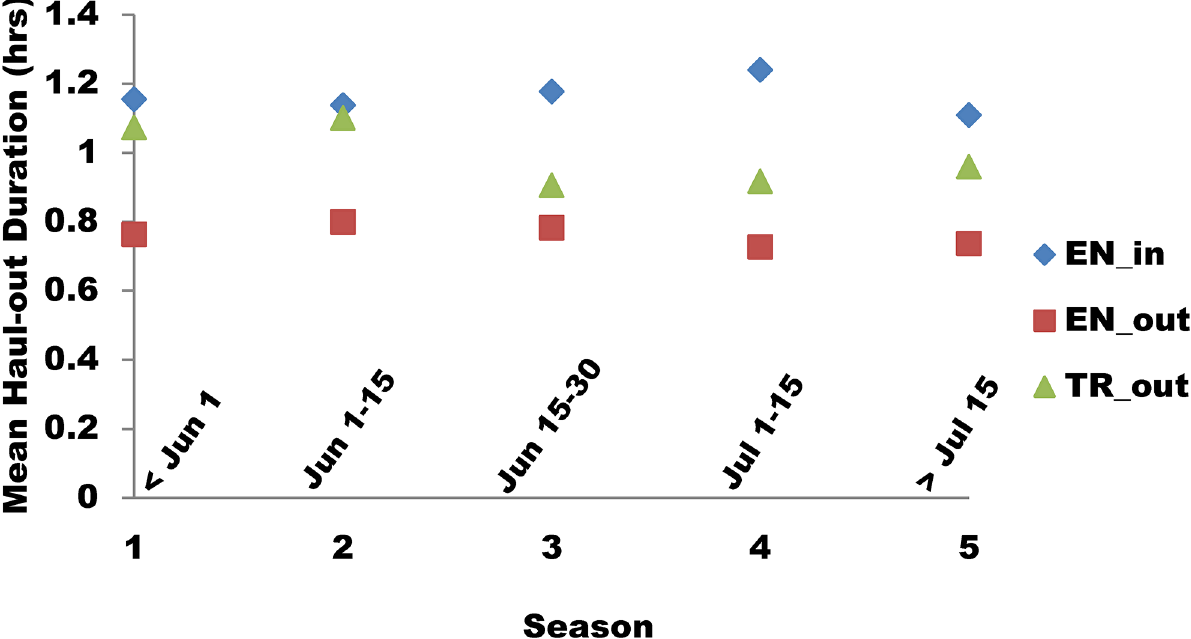
Fig 10. Haul-out duration for radio-tagged harbor seals by season and inlet. Geometric mean duration (in hours) of haulouts for seals in Endicott and Tracy Arms during each ~2 week